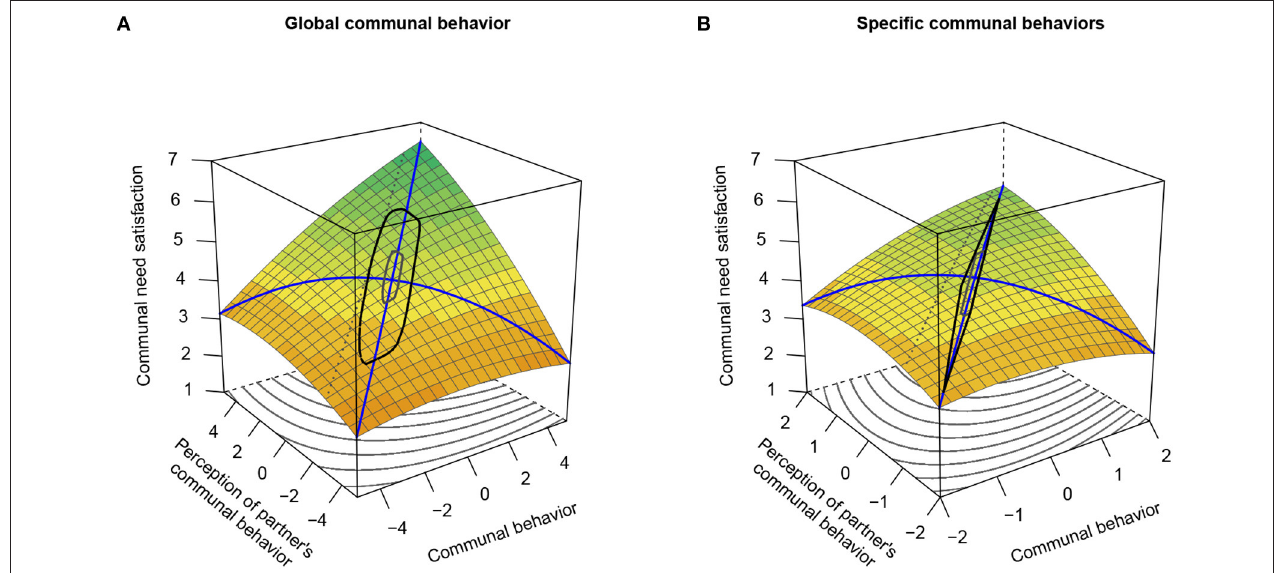
FIGURE 4 | Response surfaces for the prediction of momentary communal need satisfaction by individuals’ momentary communal behavior and perceptions of their partners’ momentary communal behavior. (A) Global communal behavior. (B) Specific communal behaviors. Figure available at: https://osf.io/2fz5w/ under a CC-BY4.0